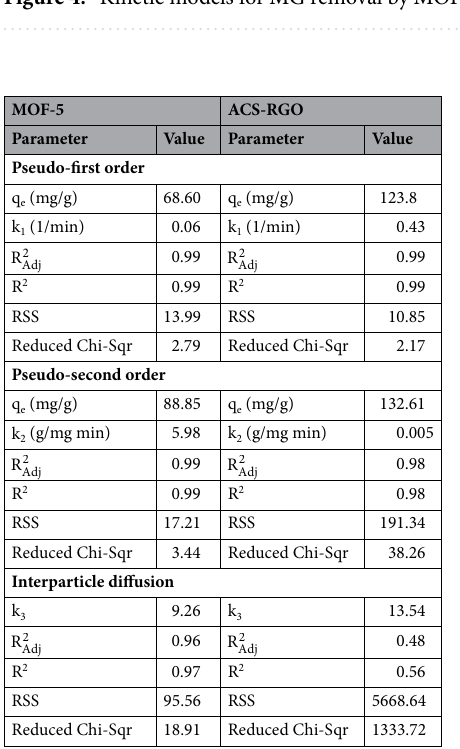
Figure 4. Kinetic models for MG removal by MOF-5 and ACS-RGO (MG: 50 mg/L, adsorbent: 0.4 g/L).